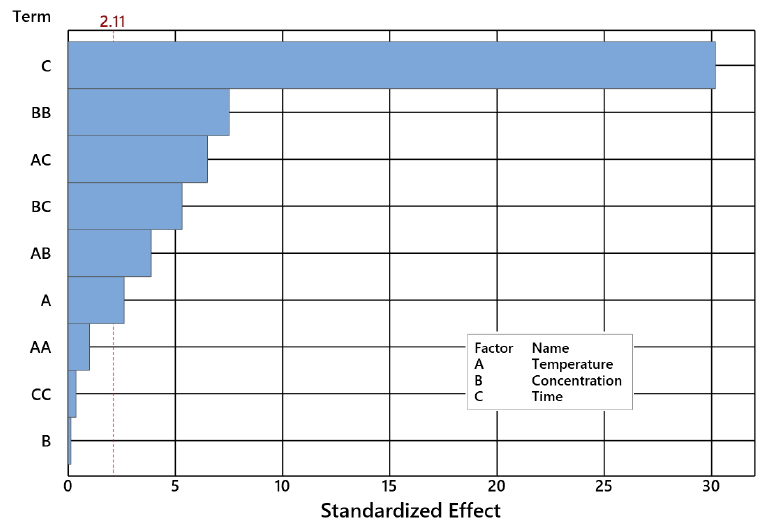
Figure 7. Pareto chart of the standardized effects of CL selectivity plot for α = 0.05. Regression Equation in Uncoded Units